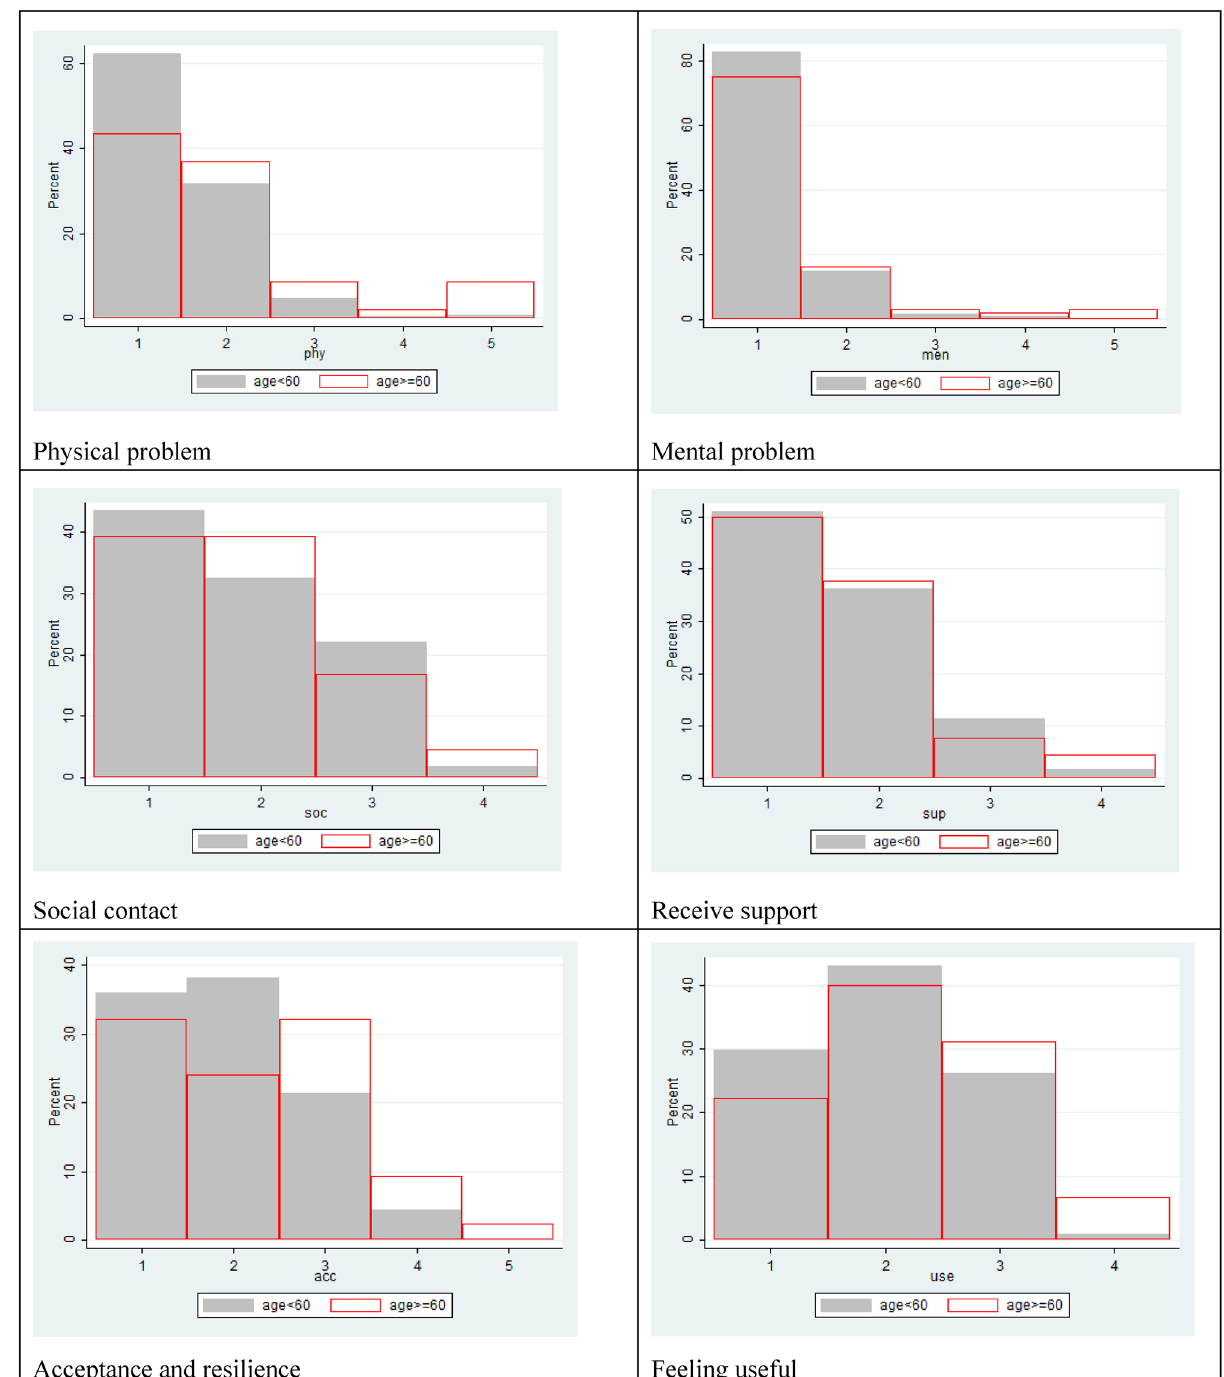
Figure 3. Item distributions between two age